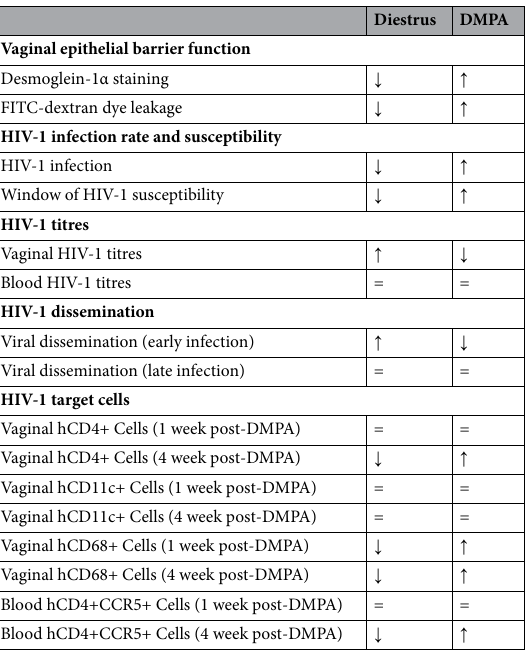
Table 2. A summary of the study results. An upward arrow ( ↑ ) indicates the factor of interest was significantly greater in that group (Diestrus vs. DMPA), while an equals sign (=) indicates groups were similar, and a downward arrow ( ↓ ) indicates the factor of interest was significantly